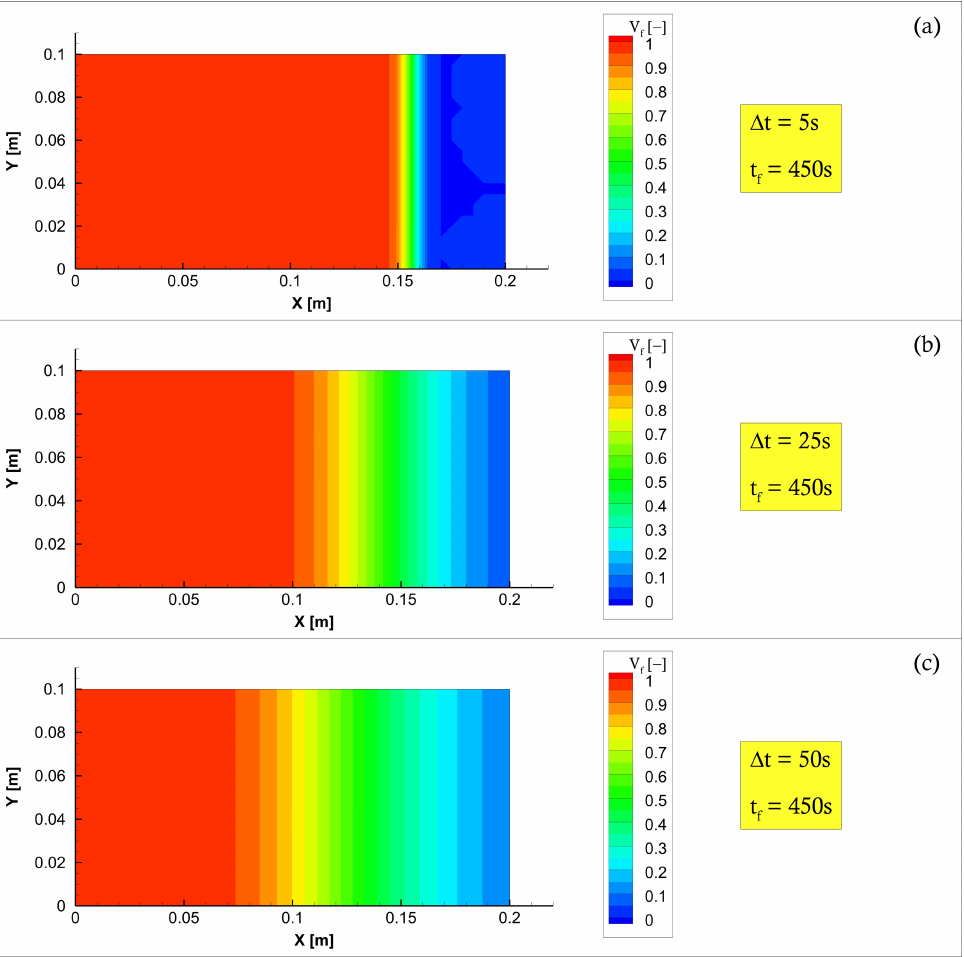
Figure 4. Numerical rectilinear/channel flow saturation throughout a porous medium with 50% aggregate porosity ( φ o ) at a constant injection pressure for different time-step sizes: 5 s, 25 s, and 50 s. ( a ) 5 s, ( b ) 25 s, and ( c ) 50